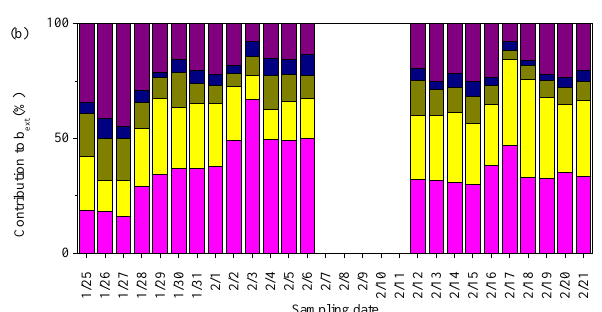
EC2 and OC1 maintained the higher contributions from FW, larger than 80 %, followed by K, K + , Al, Bi and Char-EC, with the contributions higher than 70 %. During the LF, 45 % of Ba and 41 % of Sr were from FW and the contributions to V, Bi, Fe, Be, K, K + , Al, NO − and Sb were higher than 2 20 %.